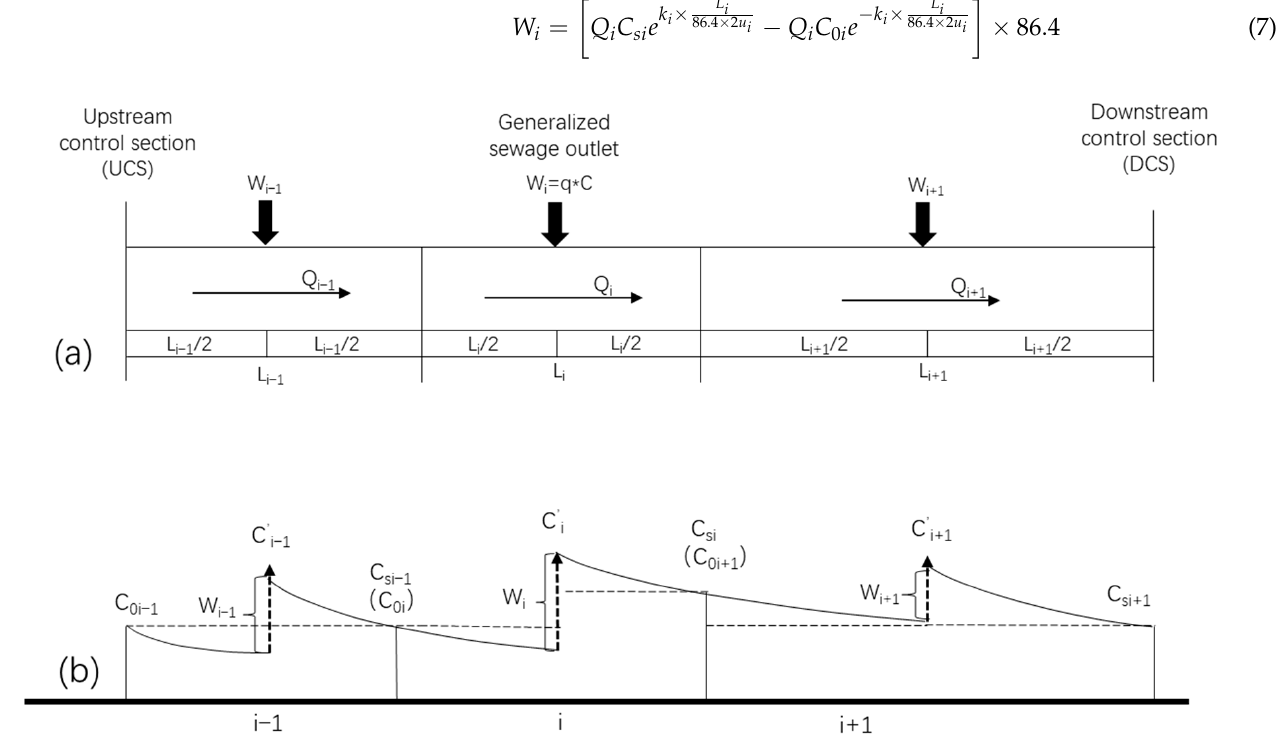
Figure 3. The diagram of the stream sections’ generalized sewage outlets ( a ) and pollutant degrada- tion processes ( b ).